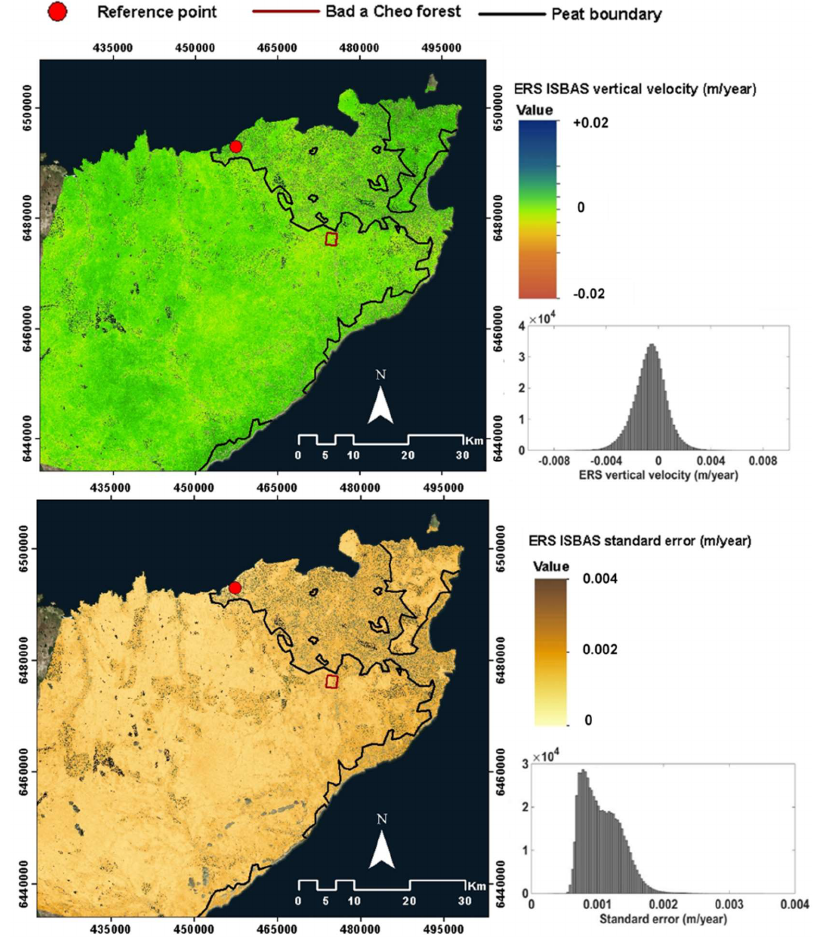
Figure 5. ERS ISBAS vertical velocity (m/year) mapwith standard error (m/year) map and their statistical distribution. The red dot represents the location of the stable reference point (location—Dounreay on the Northern coast at 456984 E, 6493400 N) used in the ISBAS processing. The black line shows the boundary of peatland over Flow Country. The red rectangle represents the location of the Bad a Cheo forest Reserve. Projection: WGS_1984_UTM_Zone 30.